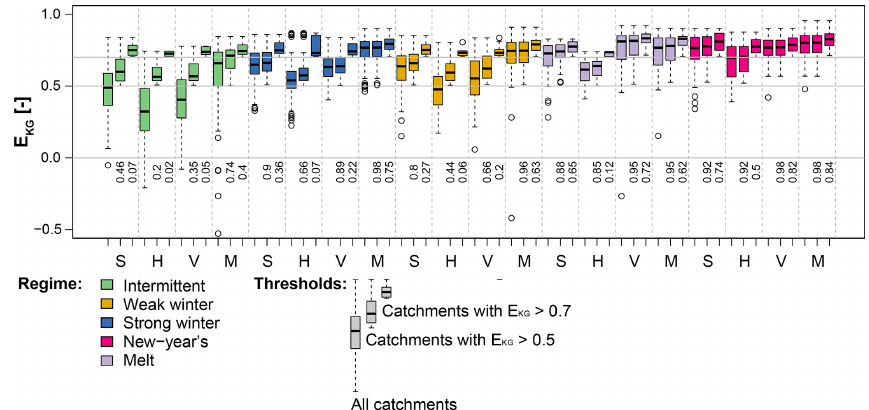
Figure 2. Model performance in terms of E KG over the period 1981–2008 for the four models SAC (S), HBV (H), VIC (V), and mHM (M) per hydrological regime: intermittent (114 catchments), weak winter (108), strong winter (176), New Year’s (50), and melt (40). For each model and regime, three boxplots are shown: all catchments, catchments with E KG > 0 . 5, and catchments with E KG > 0 . 7. The percentage [–] of catchments of a regime class above the corresponding threshold is indicated below the 0